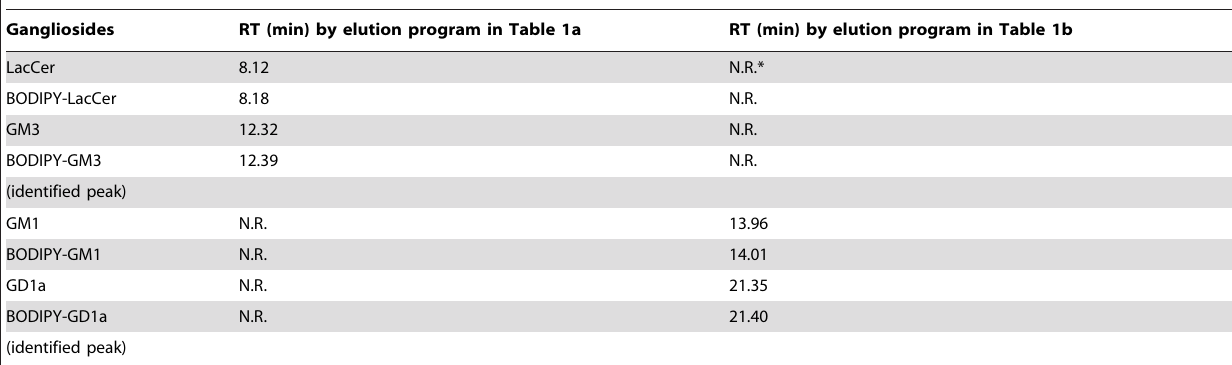
Table 2. Retention times (RT) of gangliosides and BODIPY gangliosides by two HPLC elution methods.